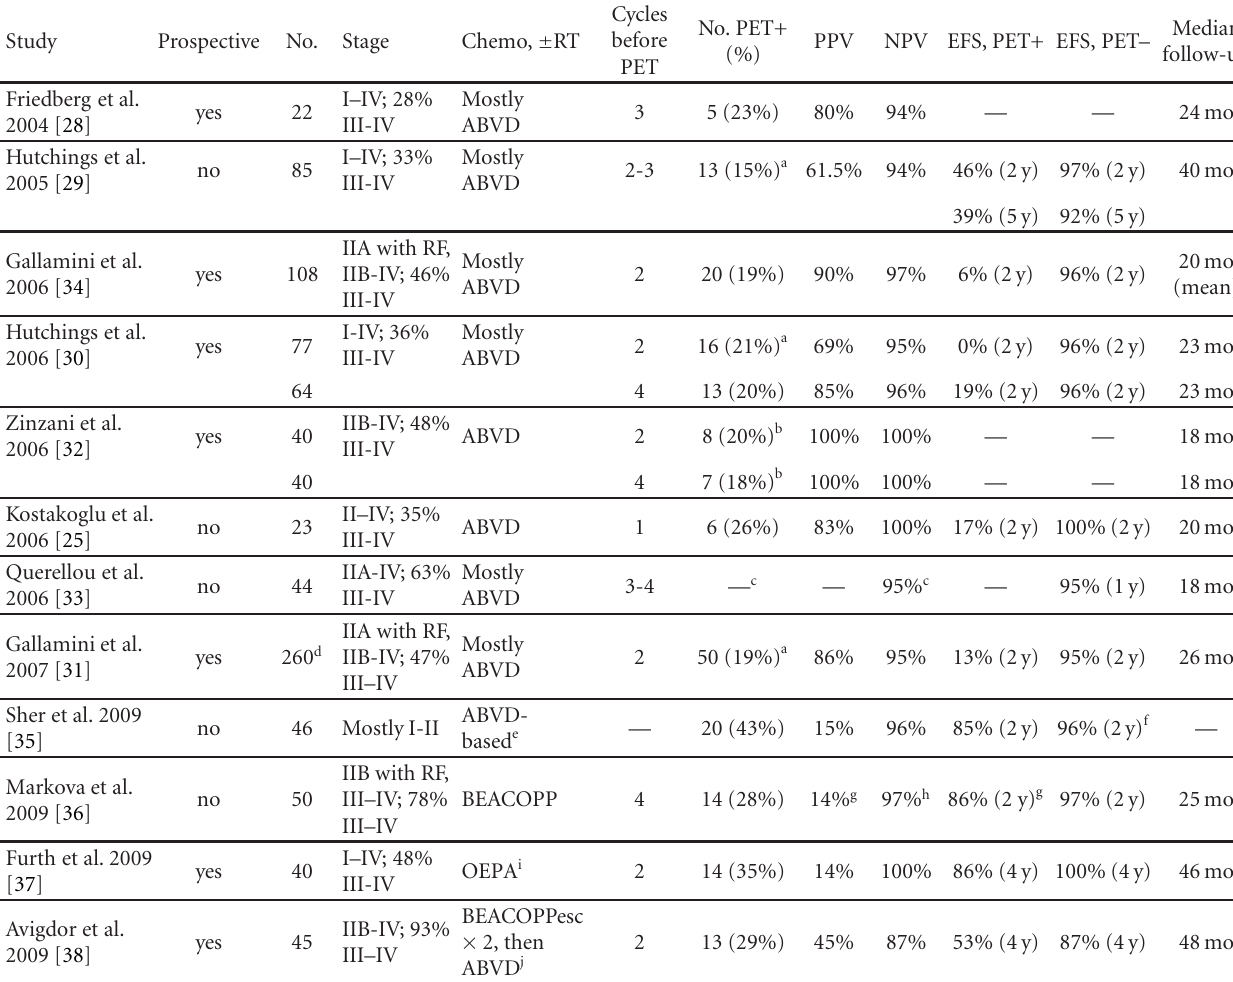
Table 1: PET during first-line chemotherapy for Hodgkin’s